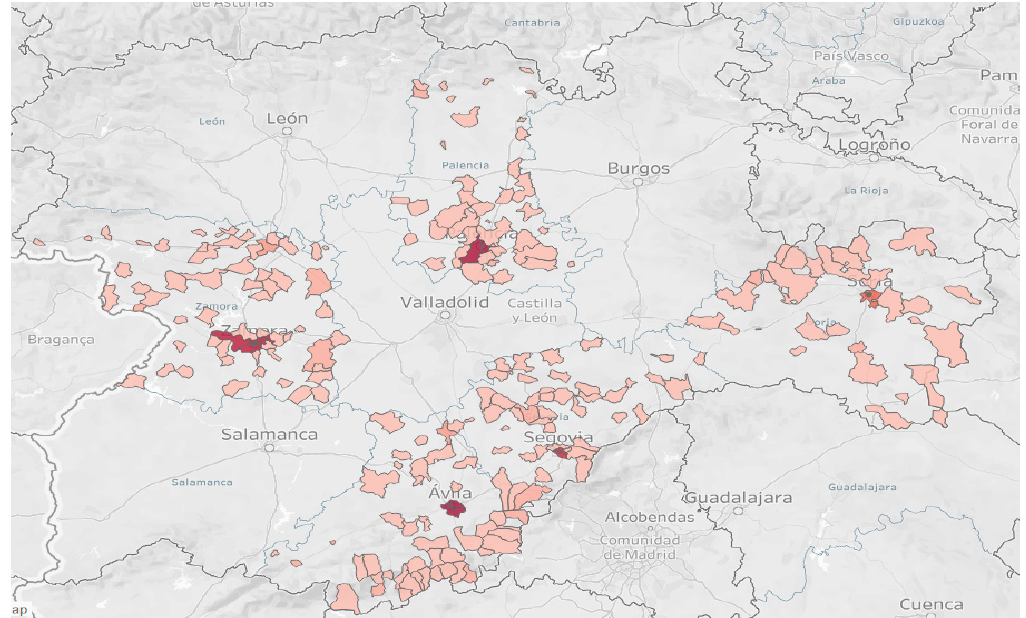
Figure 1. Access to cash in the initial situation (not including pharmacy network). Source: Own elaboration based on Table 1 y Tableau Desktop Proffesional Edition.